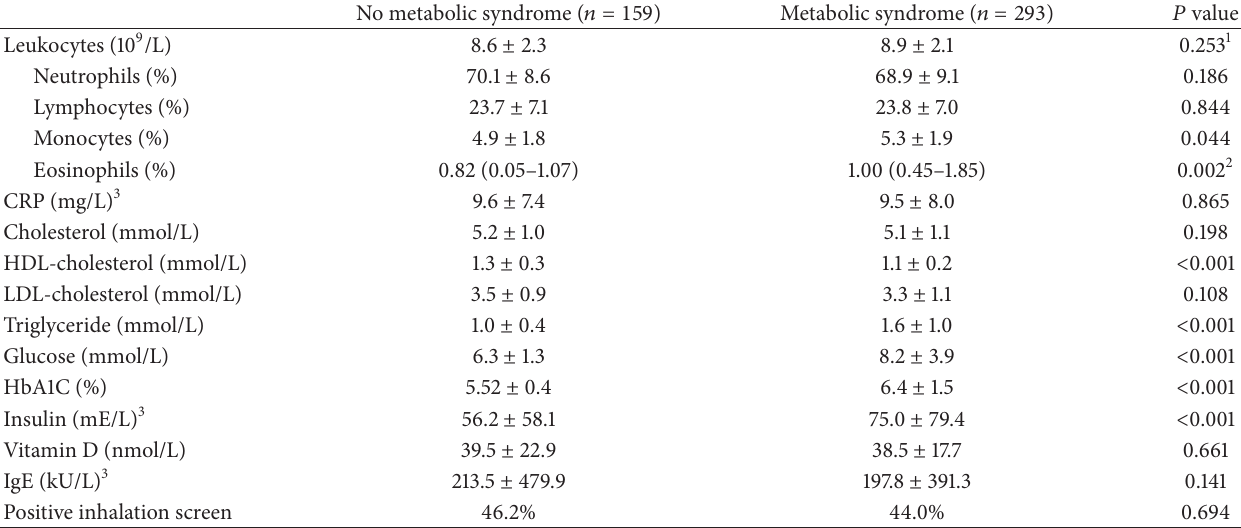
Table 2: Comparison of blood parameters between subjects with and without metabolic syndrome.